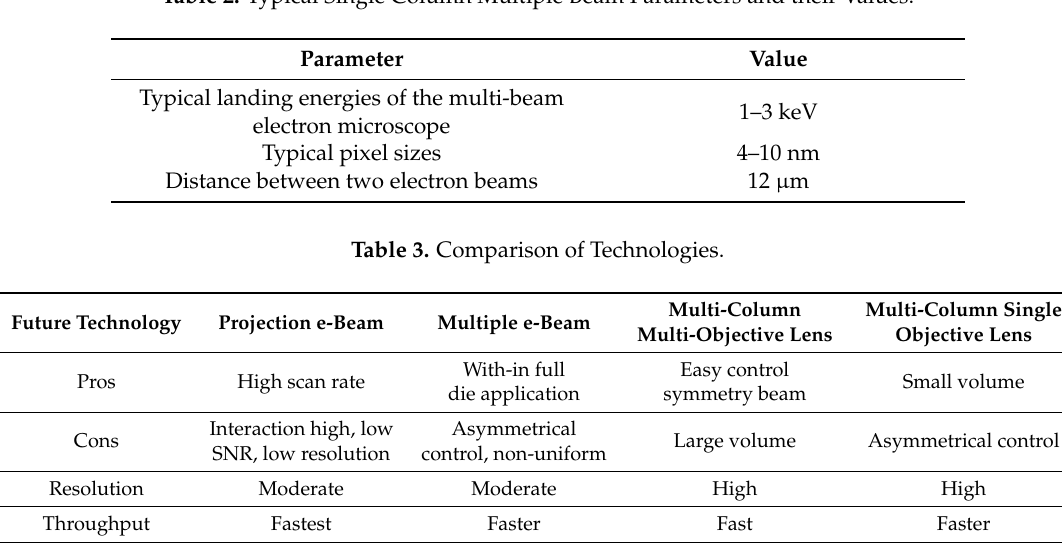
Figure 21. Multi-beam Scanning Electron Microscopes (SEM) principle using multi-beam in parallel to image a hexagonal sample area 100 micron wide. Primary electrons (solid lines, left) are focused onto the specimen & separated by a beam splitter from the secondary electrons (dotted lines, right). Typical single column multiple beam parameters and their values are shown in Table 2. The comparison of technologies is given in Table 3. Table 2. Typical Single Column Multiple Beam Parameters and their Values.